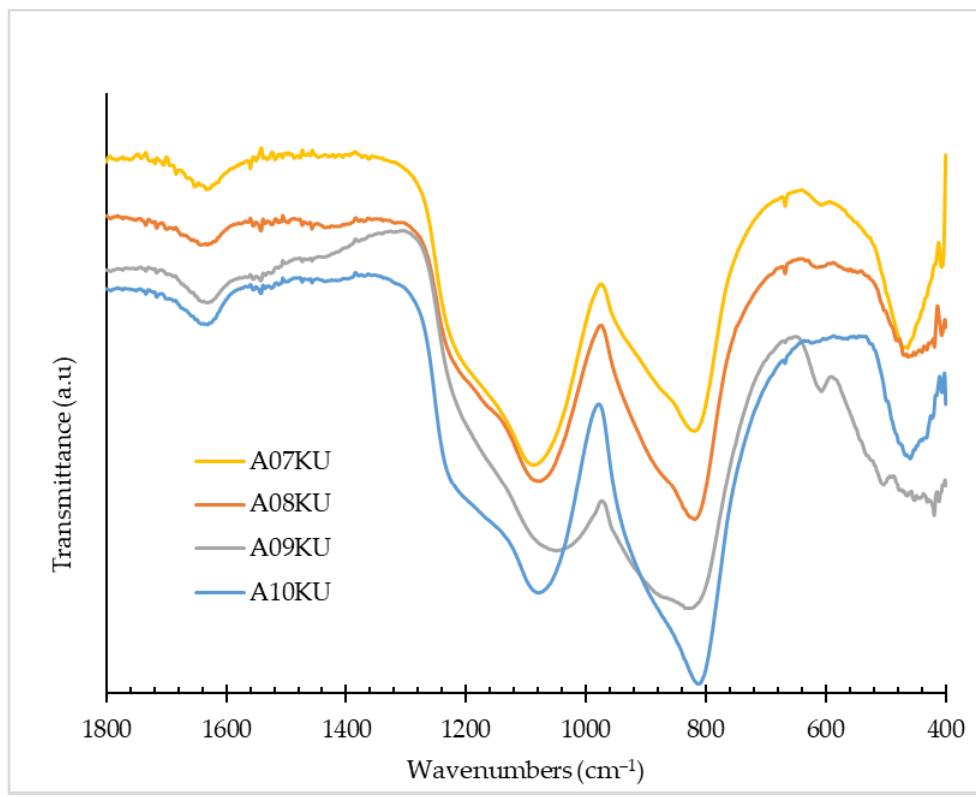
Figure 6. IR spectrum of the reduction product after calcination in air atmosphere at 700 °C. Table 4. Comparison of the absorption of the reduction products after calcination in an atmosphere of air at a temperature of 700 °C.